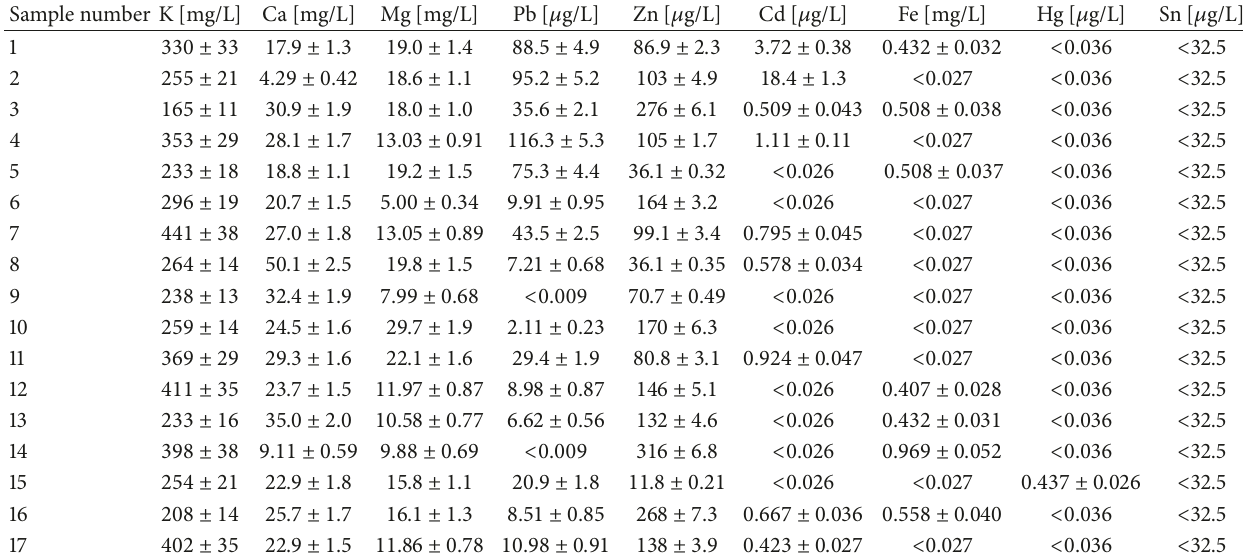
Table 5: Information on determined concentration of selected metals in fruit wine samples.